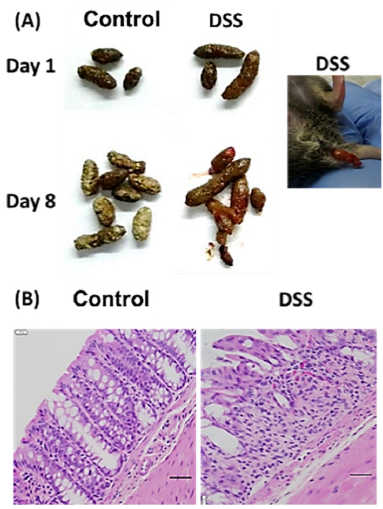
Figure 1. ( A ) Feces and ( B ) colon histology of mice with or without DSS treatment. DSS-treated mice have apparent inflammatory cell infiltration. H&E-stained colon sections (magnification, × 100).